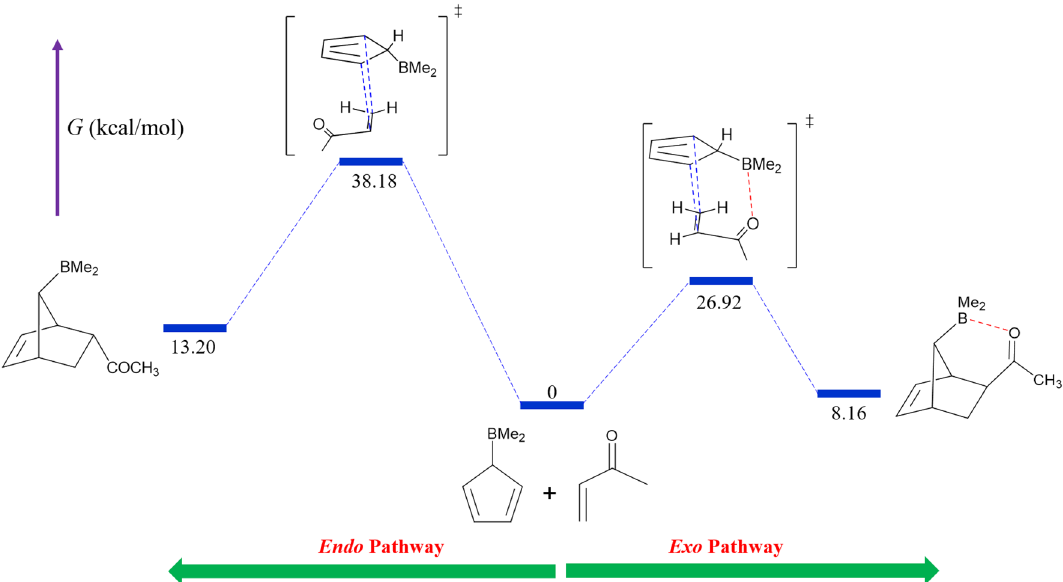
Figure 5. The reaction energy diagram for entry 2-2. Numbers represent the Gibbs free energies in kcal/mol relative to the reactants. The blue and red dashed lines represent the newly forming C–C bonds and the LAB interaction,